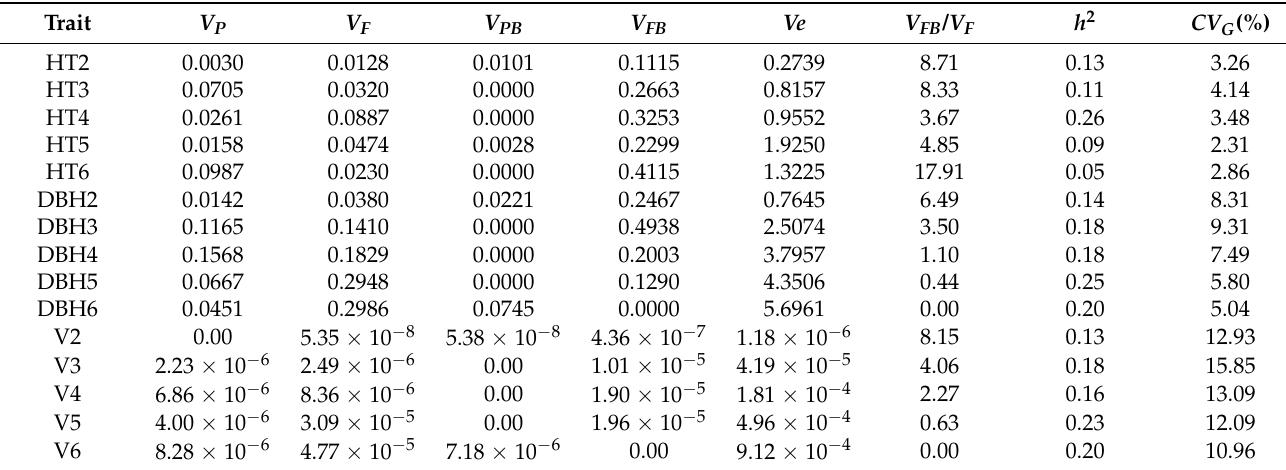
Table 4. Variance components for growth traits at different ages.